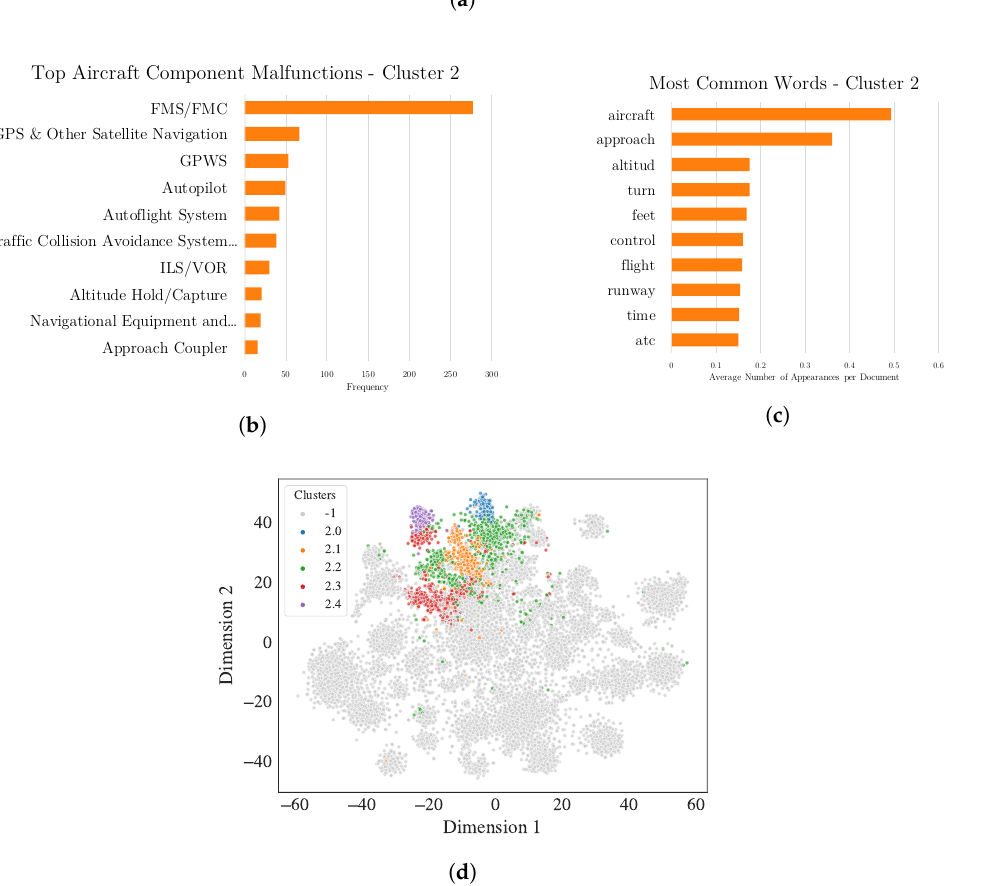
Figure 6. Highlight of cluster 2 and its sub-clusters, including most common aircraft component malfunction, and top 10 most common words in narratives for that cluster. ( a ) Highlight of Cluster 2. ( b ) Cluster 2 Aircraft Component. ( c ) Most Common Words based on Average Count per Document. ( d ) Highlight of Cluster 2